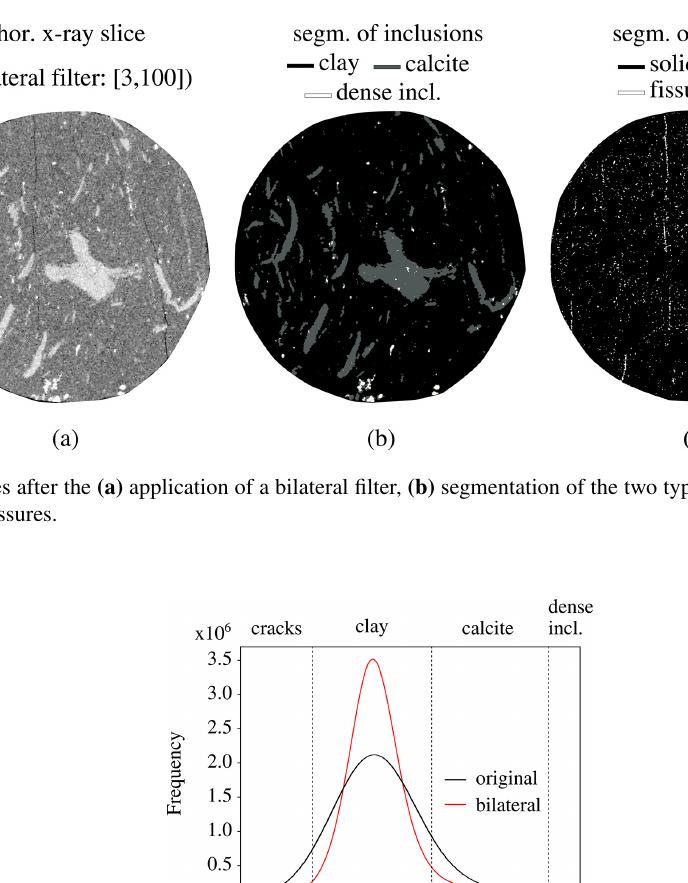
Solid Earth, 13, 1823–1841,